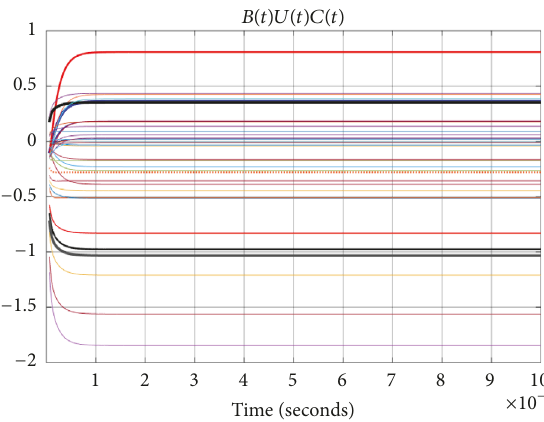
Figure 3: Trajectories of elements of the matrix 𝐵𝑈𝐶 .